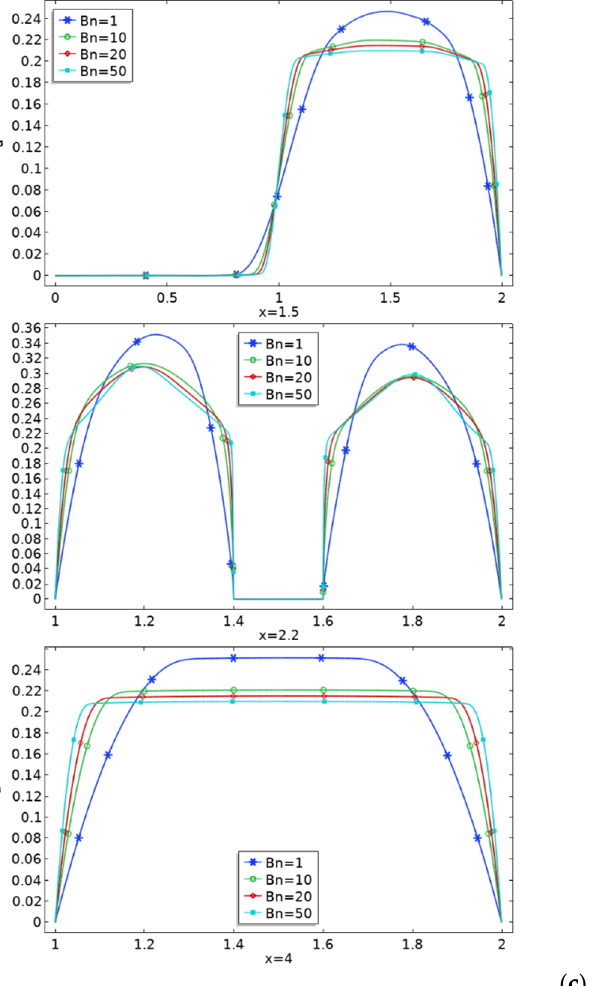
Table 2. Pressure drop for different positions of obstacle.